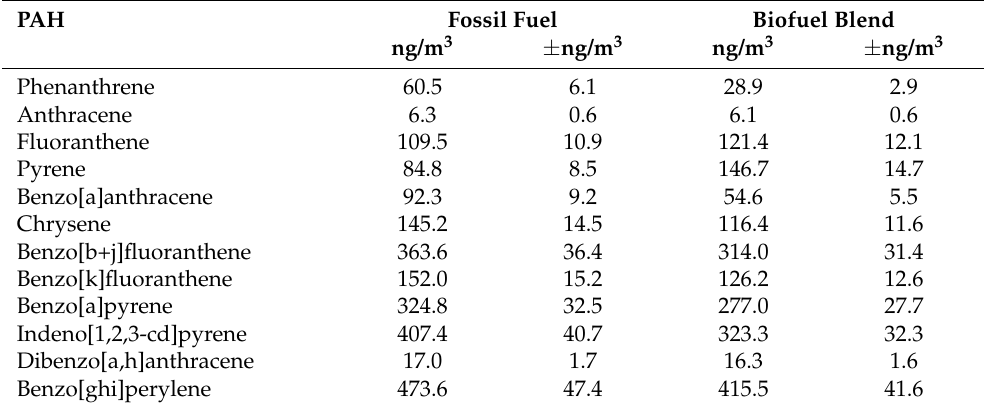
Table A2. Airborne concentration of PAHs measured on quartz filters. Values are reported as average and standard deviation pooling the whole filter obtained during the fossil fuel and biofuel tests.